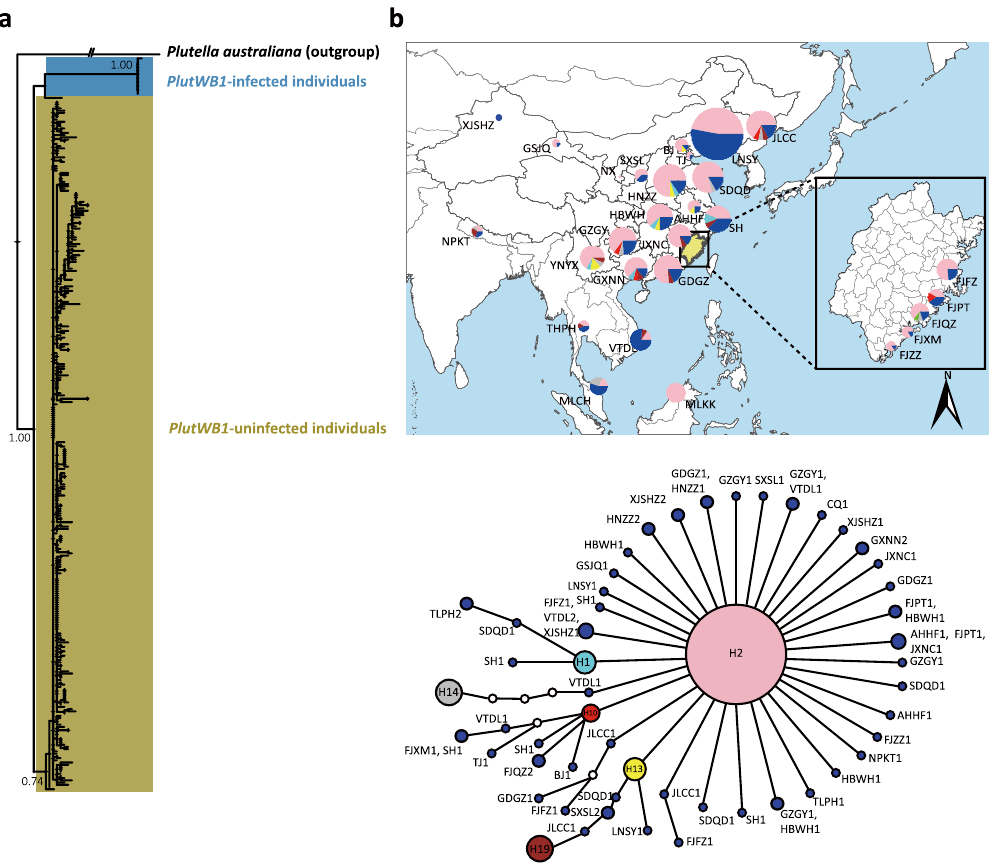
Figure 1. Phylogenetic Tree and Haplotype Network of Plutella xylostella . ( a ) Phylogeny of P. xylostella based on the concatenated CoxI , Cytb and NadhI genes using maximum likelihood algorithm with 1000 bootstraps, with P. australiana as an outgroup. ( b ) Haplotype network based on Cytb for P. xylostella . Haplotypes with frequency ≤ 4 are illustrated in blue and labeled with sampling location acronyms and numbers; small empty circles represent unsampled haplotypes. Numbers upon branches are bootstrap values > 0.5. PlutWB1 : a specific Wolbachia strain previously identified in P. xylostella